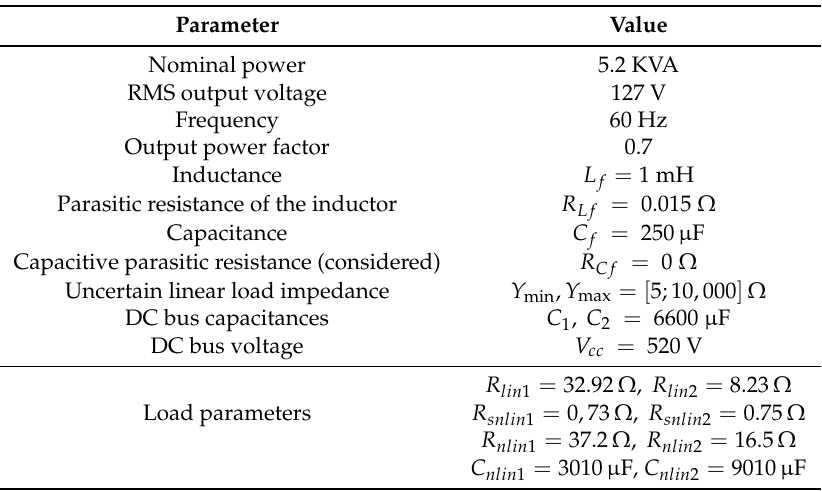
Table 1. DER system parameters.